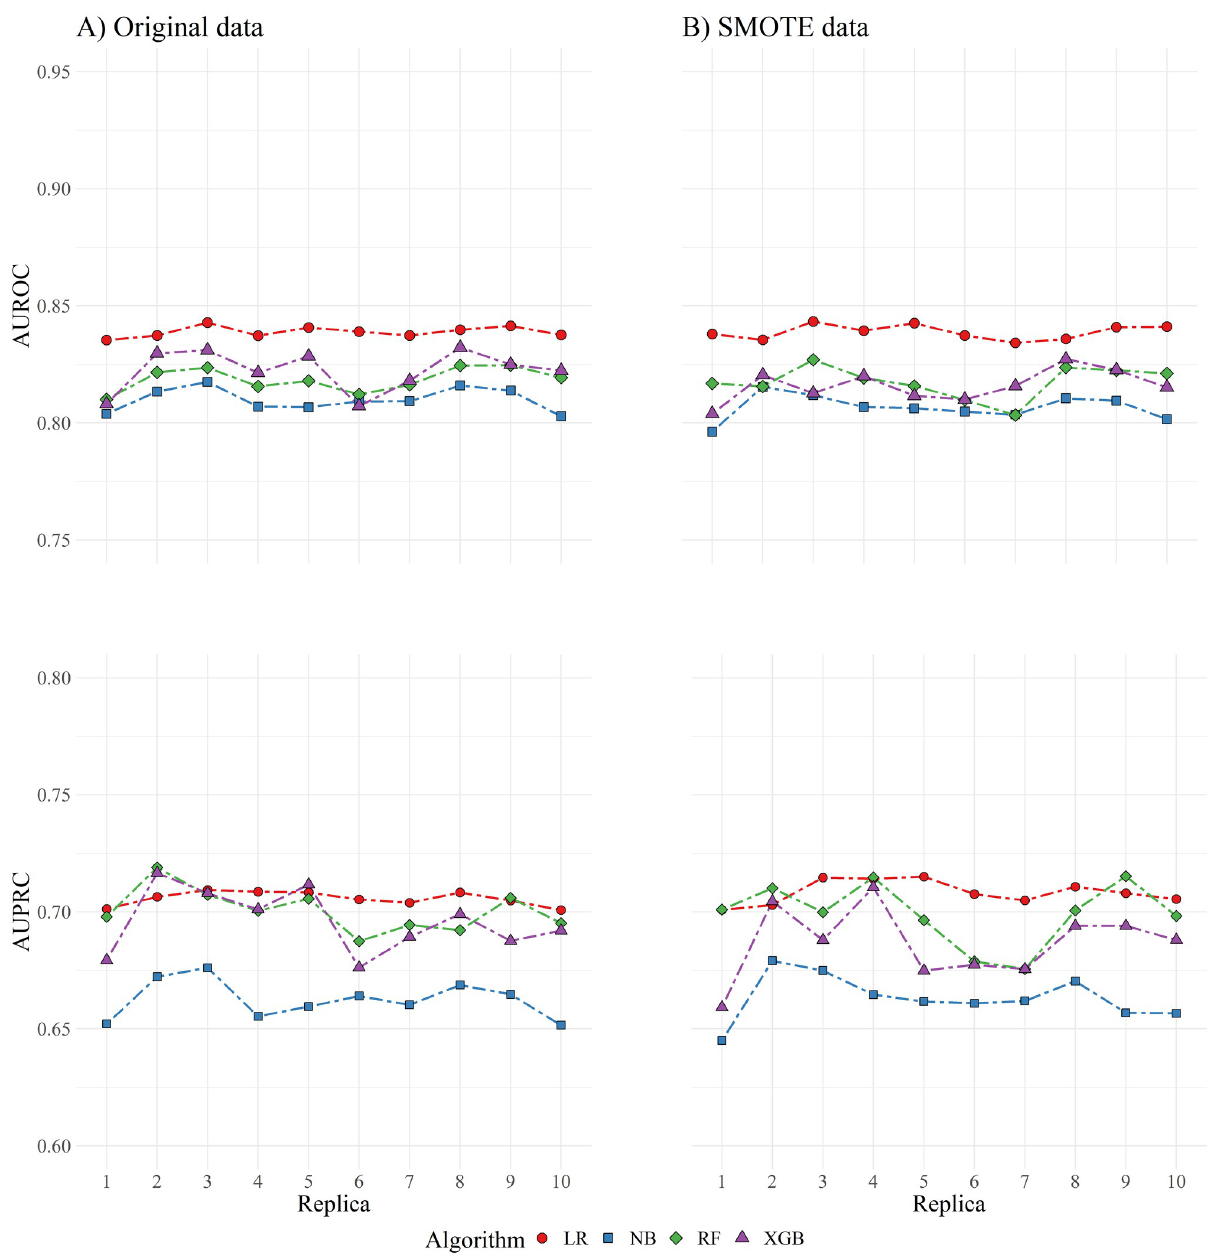
Fig 1. Comparison of areas under the ROC and PR curves, for each replica of the dataset. On the left column are presented the results using original sample data, and on the right column the results using SMOTE sample data. AUROC: area under the receiver operating characteristics curve; AUPRC: area under the precision-recall curve; LR: logistic regression; NB: naive bayes; RF: random forest; XGB: extreme gradient boosting; SMOTE: synthetic minority oversampling